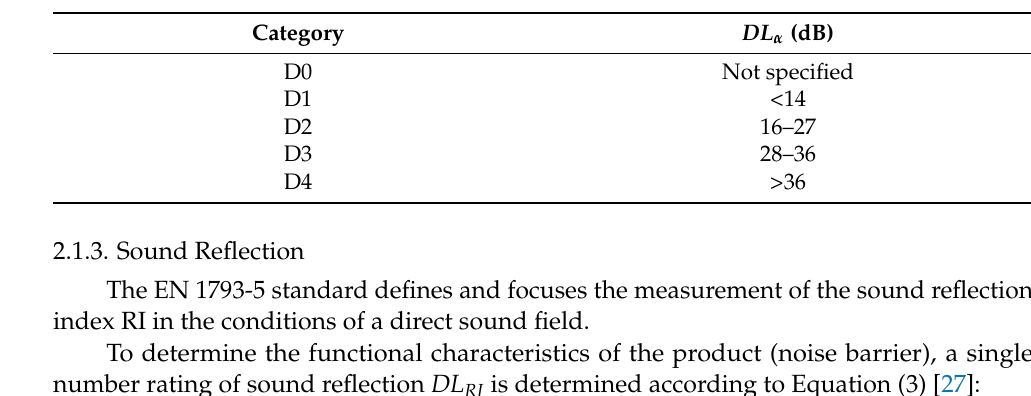
Table 2. Airborne sound insulation categories